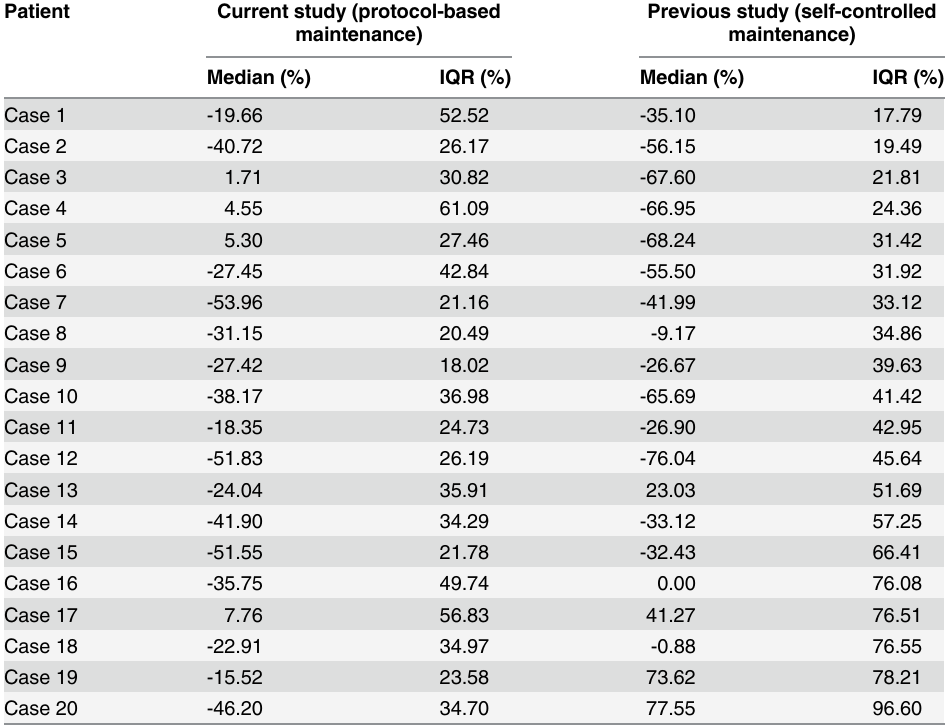
Table 5. Relative bladder volume change for each patient.